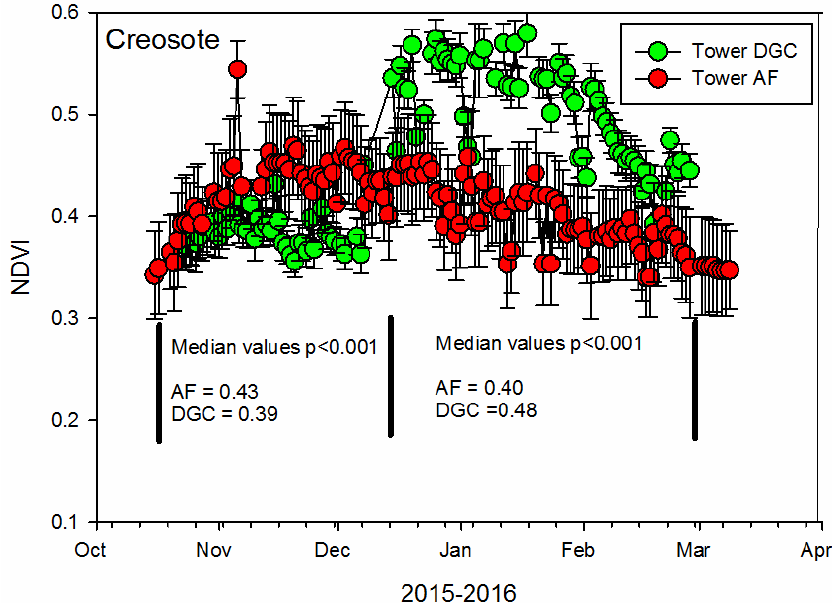
Figure 7. NDVI (overhead sensors) of creosote canopies near tower DGC and AF over a 5-month period with significant ( p < 0.001) separation during the late fall/winter and late winter/early spring periods in 2015–2016.